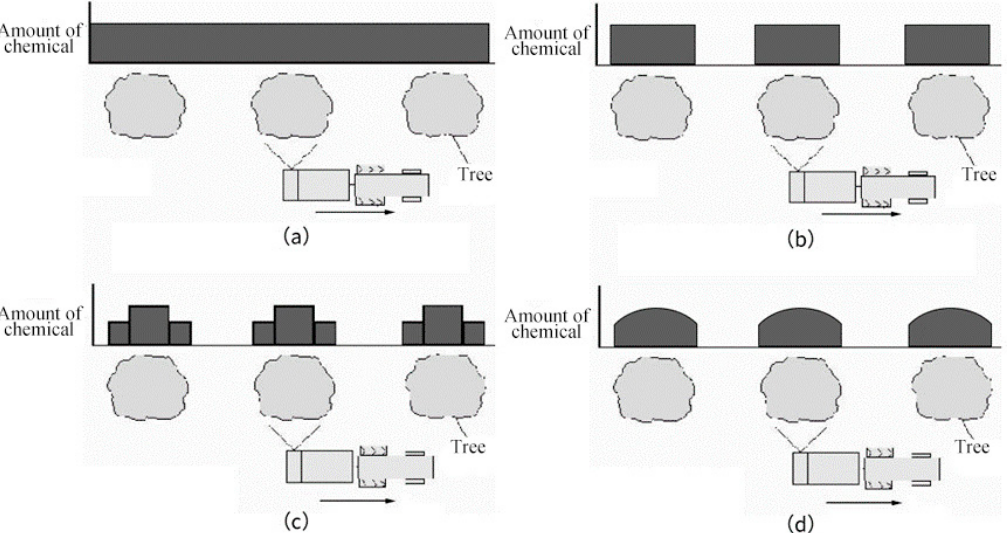
Figure 12. Quantity of chemicals applied by a constant-rate sprayer ( a ) and variable-rate sprayers with the ON/OFF application mode ( b ), the discrete application mode ( c ), and the continuous application mode ( d ) (partially cited from Molt ó et al.